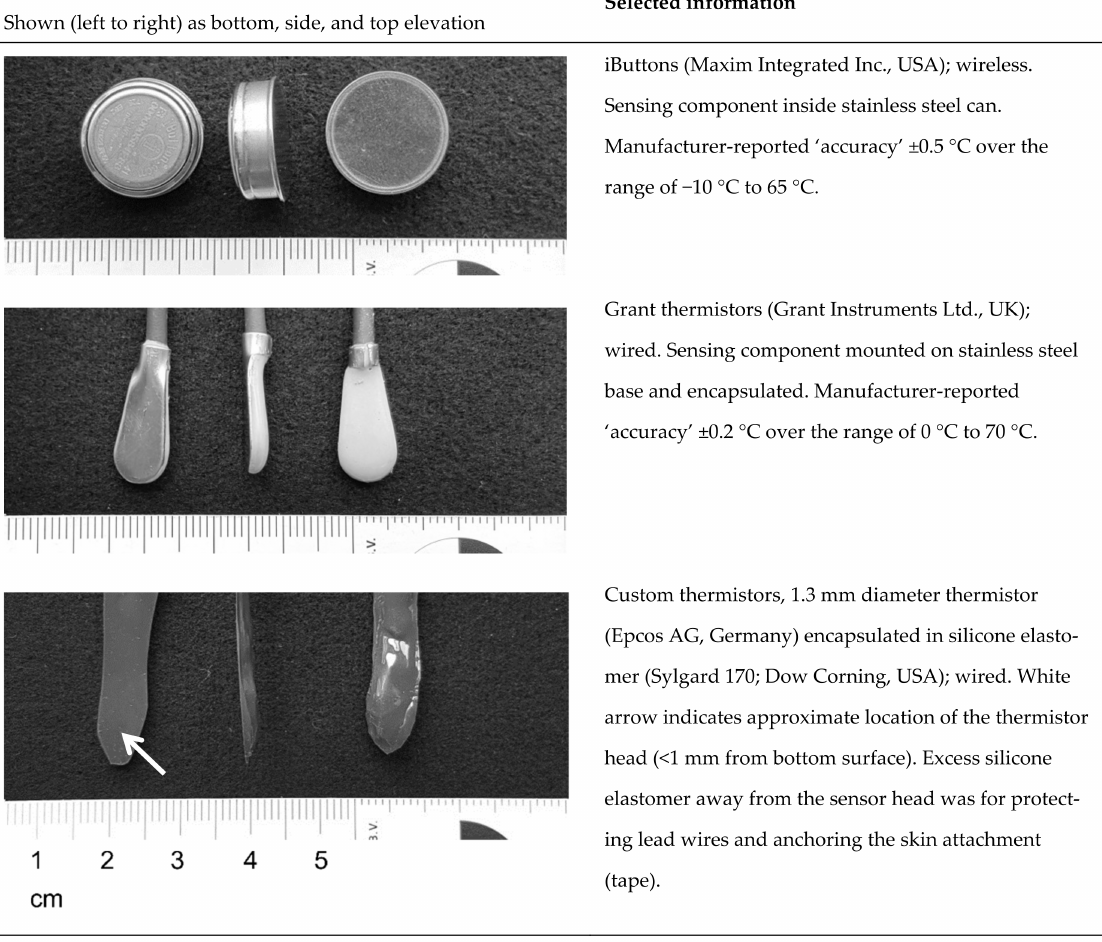
Figure 2. Skin temperature sensors and selected